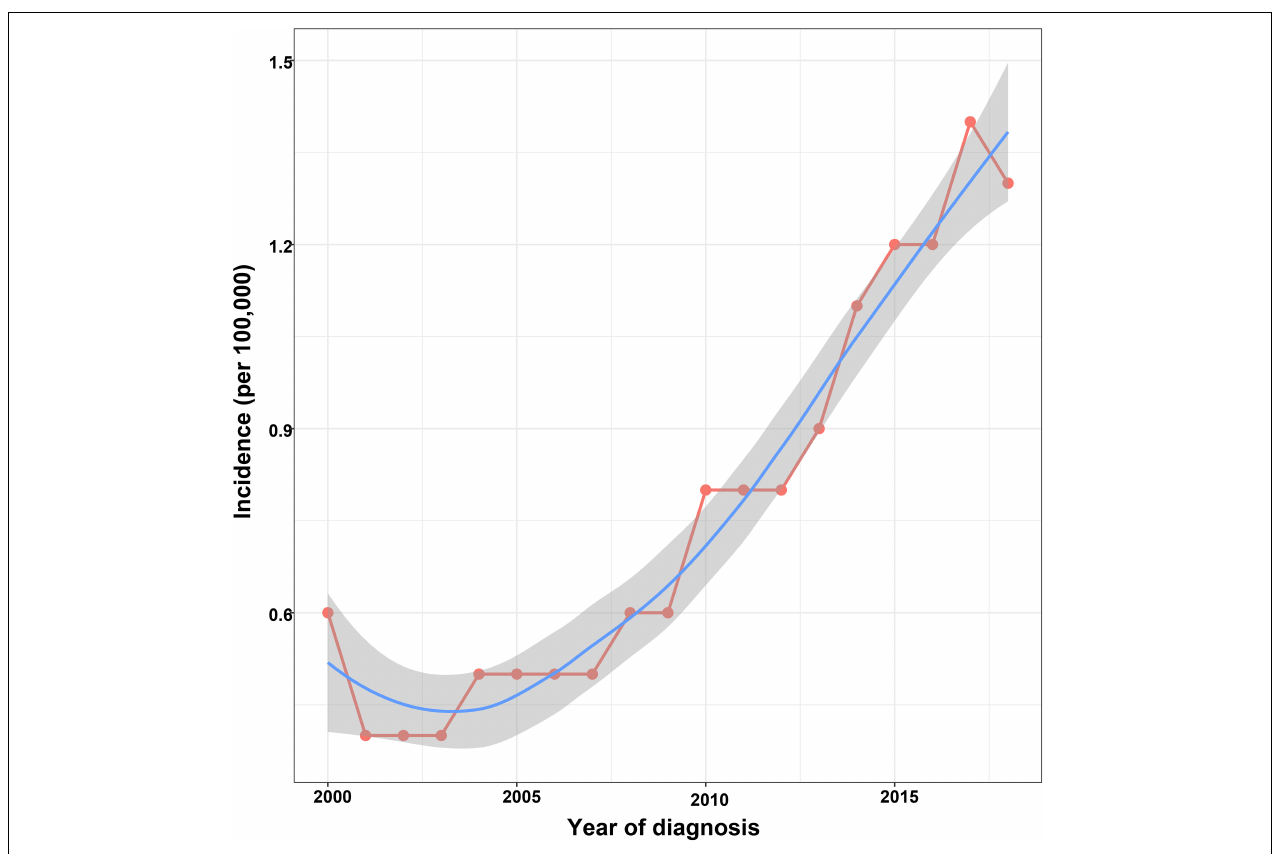
FIGURE 2 | Incidence trend of patients with